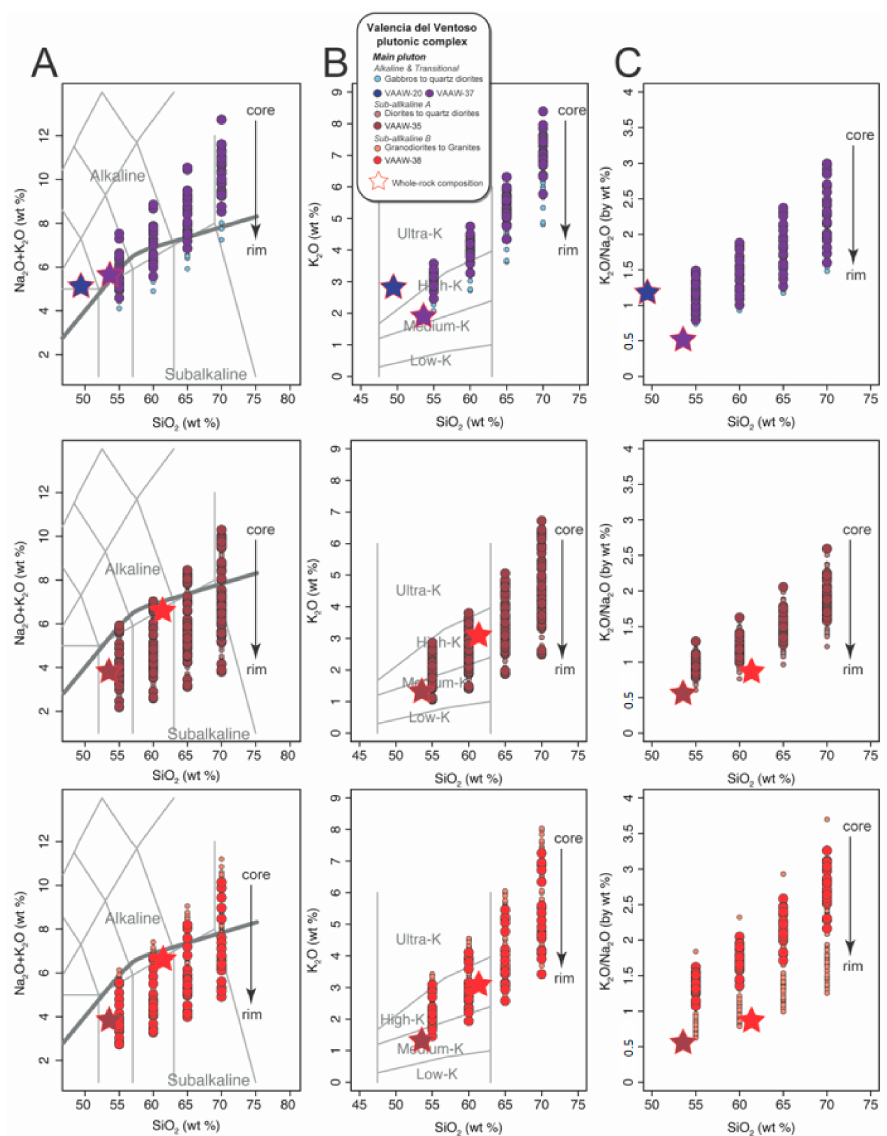
Figure 10. Estimated composition of melts in equilibrium with amphibole from intermediate and border facies rocks from the Valencia del Ventoso main pluton. Compositions were estimated using the partition coefficient expressions derived from [2]. ( A ) Total alkali versus SiO 2 (wt.%) (TAS); ( B ) K 2 O (wt.%) versus SiO 2 (wt.%); ( C ) K 2 O/Na 2 O versus SiO 2 (wt.%). Liquid compositions estimated for compositional data of amphibole from [44] (smaller lighter symbols) are shown for comparison. Stars are the whole rock composition of the samples VAAW-20, VAAW-35, VAAW-37, and VAAW-38 taken from